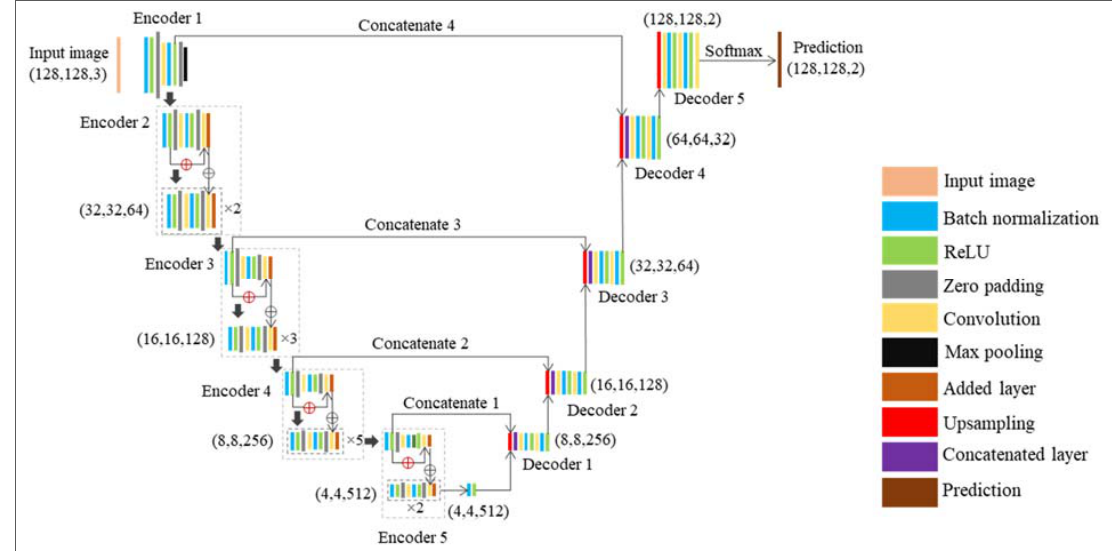
Figure 5. The general structure of ResNet34 ‐ UNet.